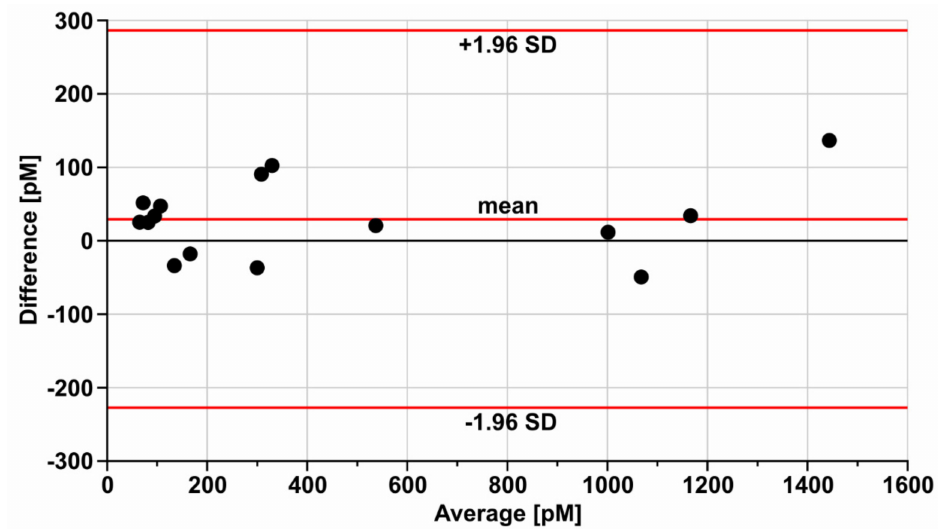
Figure 4. Bland-Altman plot for the HE4 results determined by a standard method (Elecsys HE4